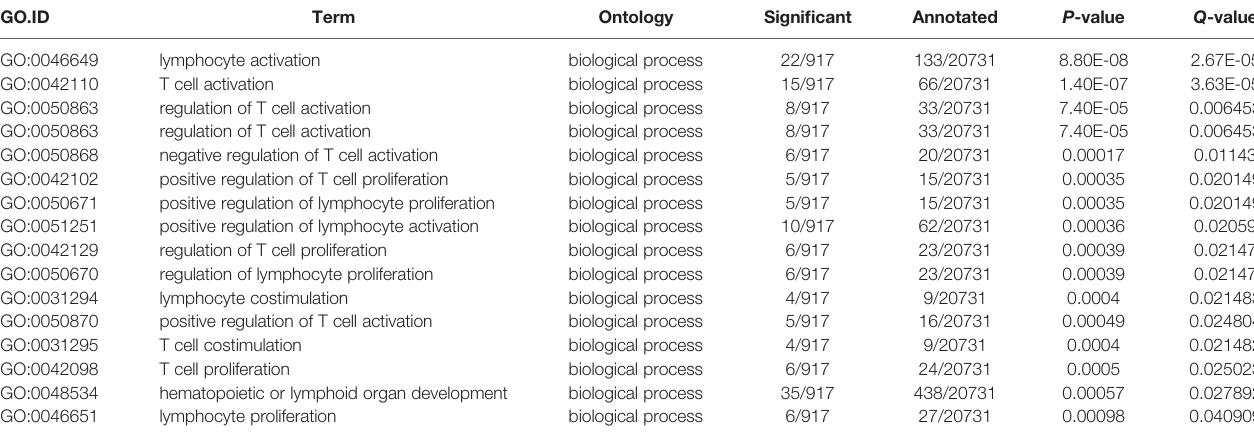
TABLE 2 | The signi fi cantly downregulated GO terms involved in adaptive immunity in Mut-10d_vs_WT-10d.